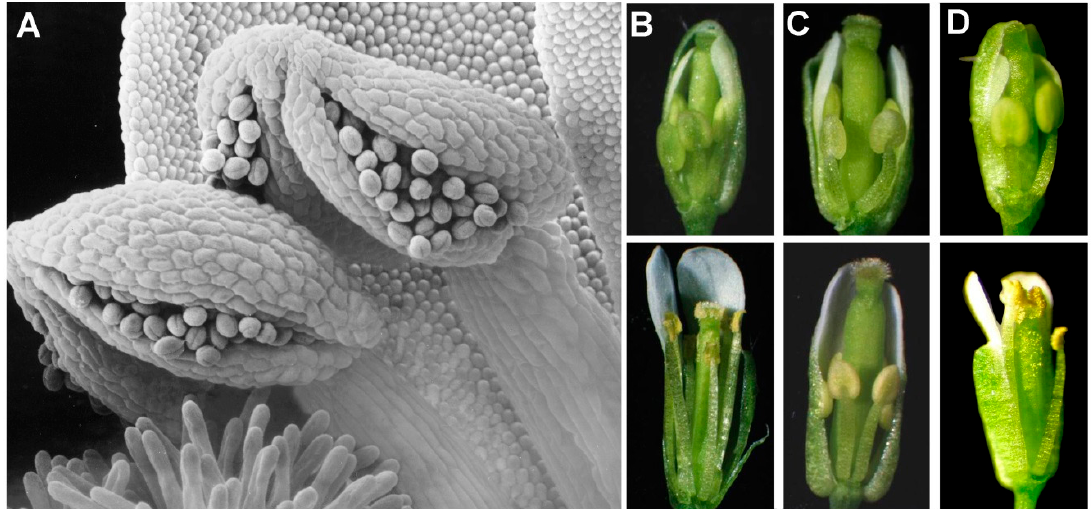
Figure 1. Two Arabidopsis mutants that unlocked the mechanism of jasmonate signaling. ( A ) Self-pollinating species like Arabidopsis depend on coordinated development of the anther, the pollen, and the anther filament to ensure that the mature anther is positioned above the stigma at the time of anther dehiscence and pollen release. ( B ) In wild-type flowers, filament elongation, pollen maturation, and dehiscence all depend on jasmonate signaling. ( C ) The coi1 ( coronatine insensitive1 ) mutant is male-sterile and does not respond to jasmonate treatment. ( D ) In the fad3–fad7–fad8 triple mutant ( fad = fatty acid desaturation ) (and other jasmonate-synthesis mutants), filament elongation, anther dehiscence, and pollen function are all defective as in coi1 , but treating flower buds with jasmonate makes the flowers as fertile as wild type. In ( B – D ), the upper panels show stage 11 flowers and the lower panels stage